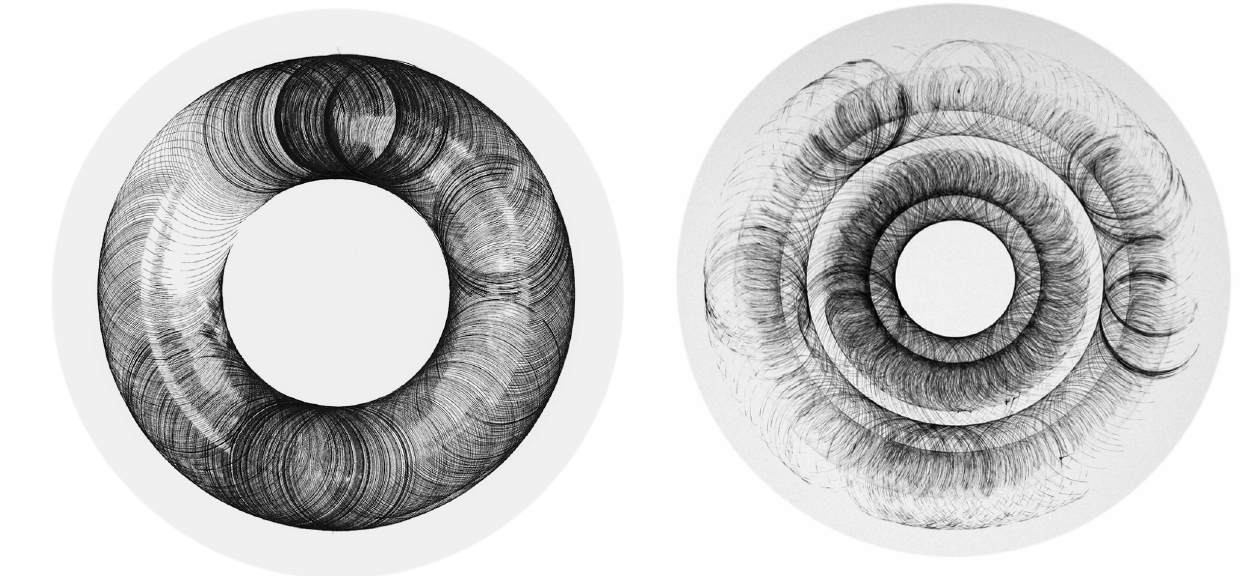
Figure 8 | Mixer Drawing Nr. 11. Intertwined circles caused by different pen